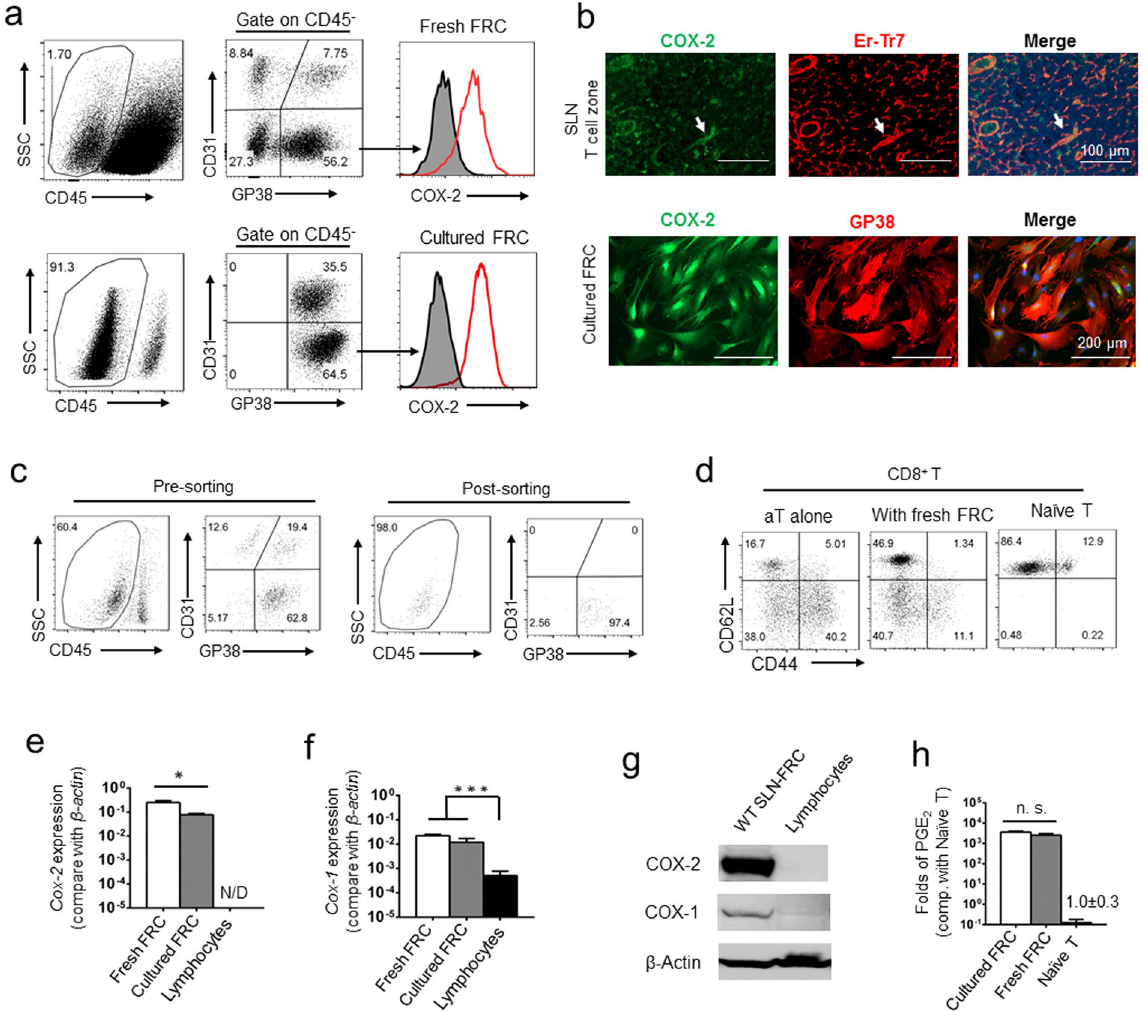
Figure 4. Hyperactive COX-2/PGE 2 axis is an intrinsic property of FRC in situ during homeostasis. ( a ) Flow cytometry analysis of COX-2 expression in freshly isolated and cultured SLN-FRCs following intracellular staining (red line) compared with isotype control (gray). ( b ) Immunofluorescence staining of COX-2 (green) and Er-Tr7 (red) in cryosection of SLN (top row) and cultured FRCs (bottom row) with COX-2 (green) and GP38 (red), overlaying with nuclear DAPI staining (blue). Scale bars, 100 μ m (top row) and 200 μ m (bottom rows), respectively. ( c ) Sorting strategy of freshly isolated SLN-FRCs (CD45 − CD31 − GP38 + ). ( d ) Isolated CD8 + T cells were stimulated by anti-CD3/28 activation beads with or without the condition medium from freshly isolated SLN-FRC. T cell activation was assessed by flow cytometry analysis of CD62L and CD44. ( e , f ) Comparative analysis of Cox-2 and Cox-1 mRNA expression in freshly isolated FRCs, lymphocytes and cultured FRCs via quantitative real-time RT-PCR, which is normalized against the b-actin mRNA level of each sample. N/D, not detectable. ( g ) Cell lysates of cultured FRCs and fresh lymphocytes were subjected to SDS-PAGE gel and Western Blotting analysis to determine COX-2 and COX-1 protein expression using b-actin as the sample loading control. Cropped images of representative experimental results and the uncropped images are presented in Supplementary Fig. 7. ( h ) The accumulation of PGE 2 in the supernatant of freshly isolated and cultured FRCs was compared with that of naïve T cells. The level of PGE 2 is normalized as the production by 1 × 10 6 cells/1 ml/24 h. * P < 0.05, *** P < 0.001, n.s. = not significant. Nonparametric Mann-Whitney test. Data are representative of two to three independent experiments (mean ±